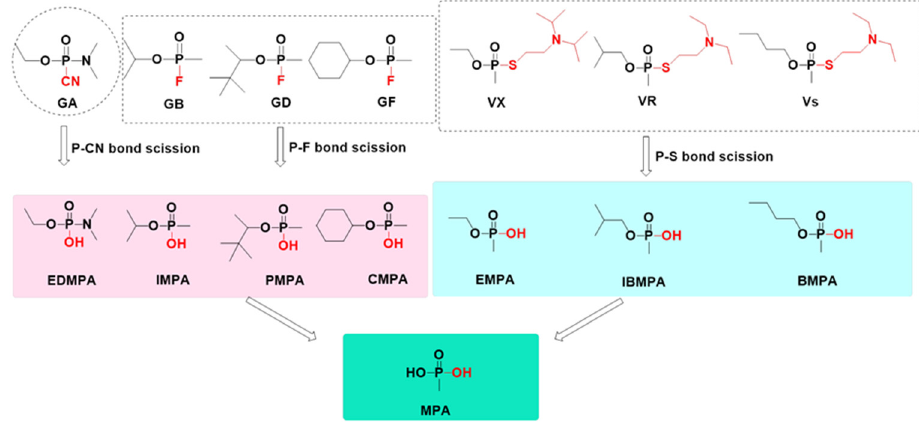
Figure 2. Stepwise degradation products and their structure.